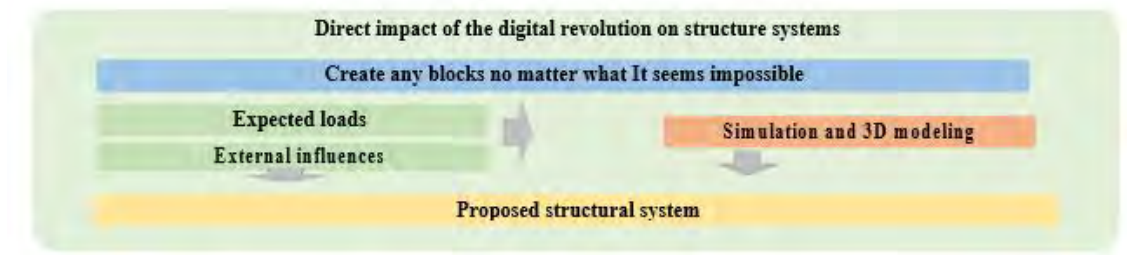
Figure 10. Direct impact ofdigital revolution on structural